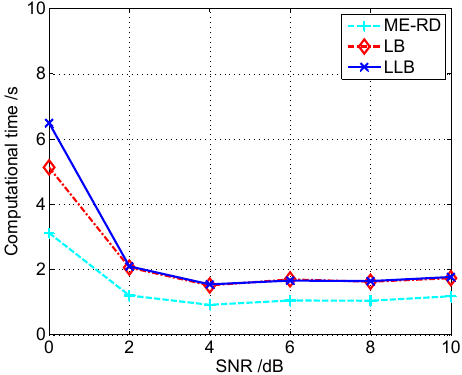
Figure 10. Comparison of computational time versus SNR for different algorithms.